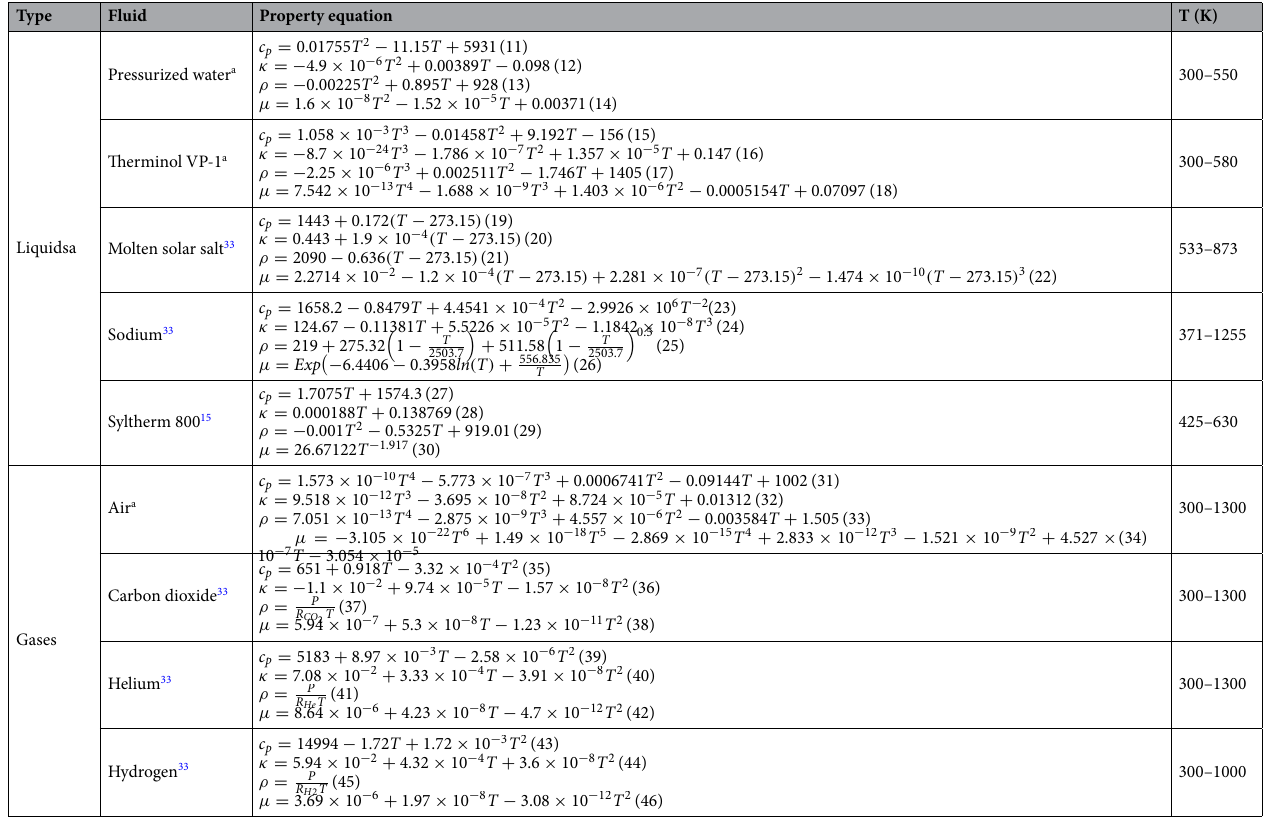
Table 1. Equations of the thermal fluid properties. a Derived by the